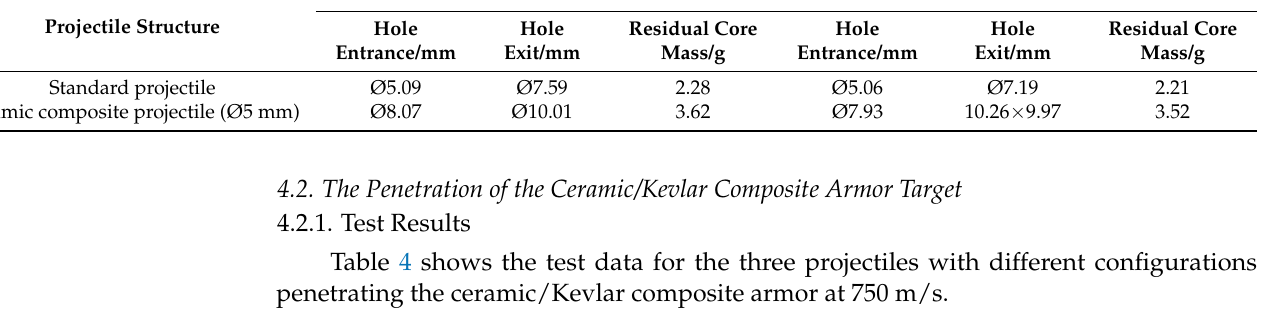
Table 4. Test results of projectile cores penetrating the ceramic/Kevlar composite armor in different structures. Projectile Structure